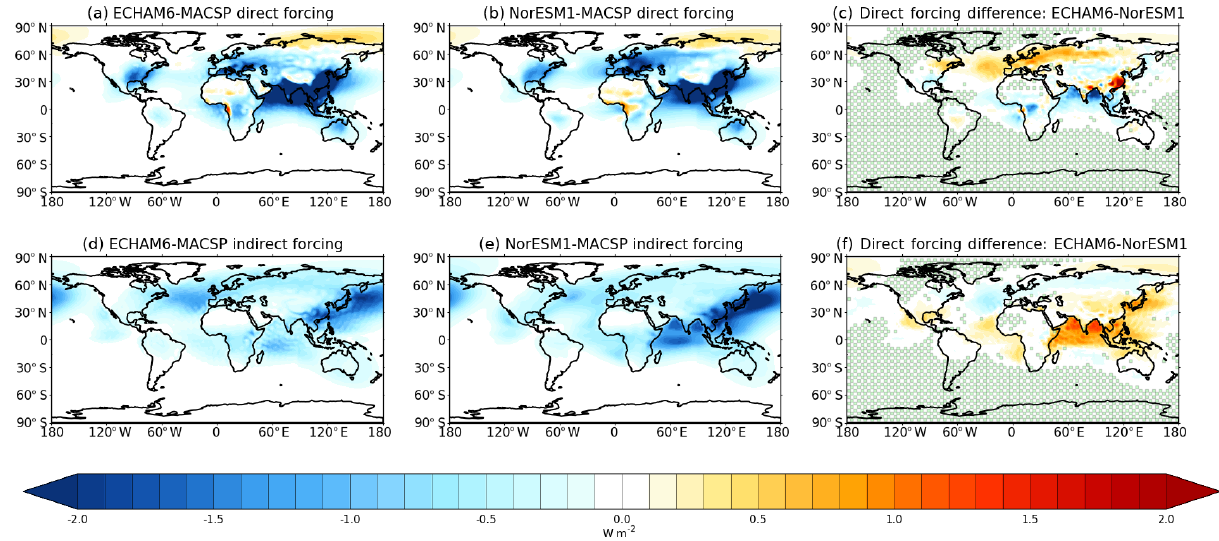
Figure C1. Instantaneous radiative forcing by anthropogenic (MACv2-SP) aerosols. Panels (a) , (b) , (c) show the direct radiative forcing, and (d) , (e) , (f) show the indirect radiative forcing produced by MACv2-SP. Green masking in panels (c) and (f) indicates areas where the difference between the models in the instantaneous radia- tive forcing is not statistically significant ( p > 0 .